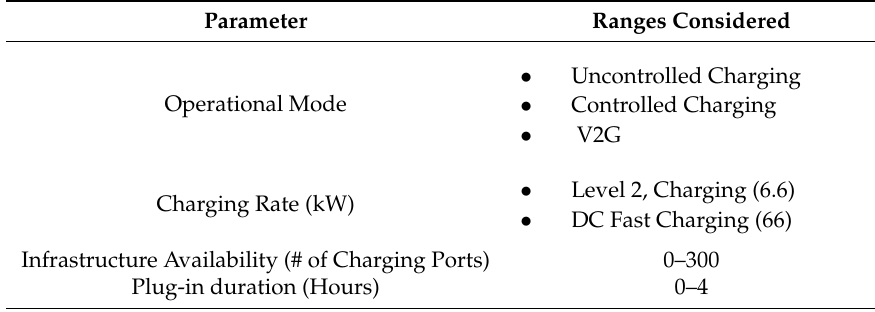
Table 2. Summary of simulation parameters and range of values considered in the case study. V2G— vehicle-to-grid.